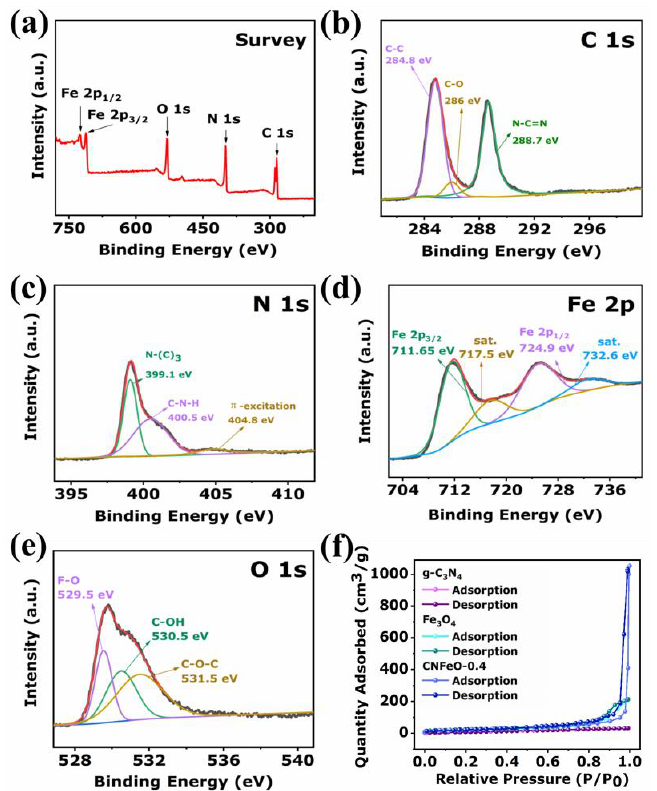
Figure 3. Full-scan XPS spectrum ( a ) and C 1s ( b ), N 1s ( c ), Fe 2p ( d ), and O 1s ( e ) of